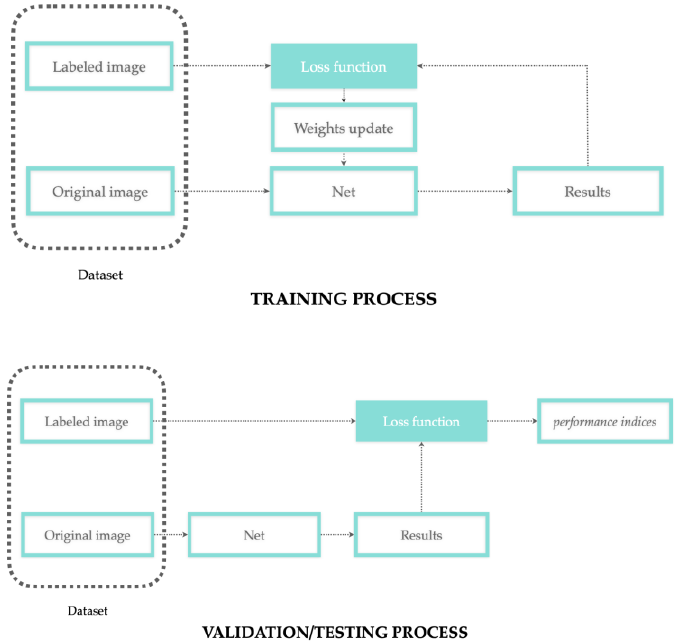
Figure 3. Training process with weights update workflow (top); validation/testing process workflow performed on different subsets (bottom).